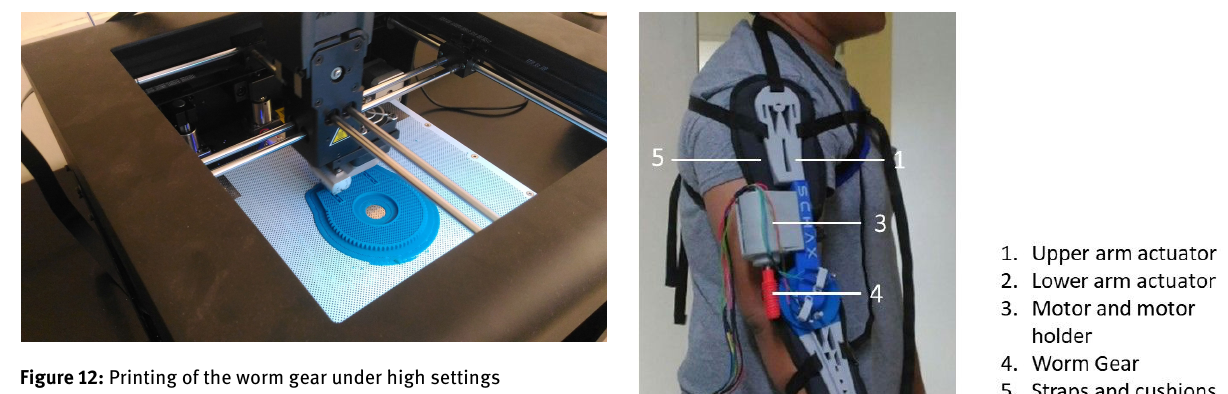
Figure 12: Printing of the worm gear under high settings